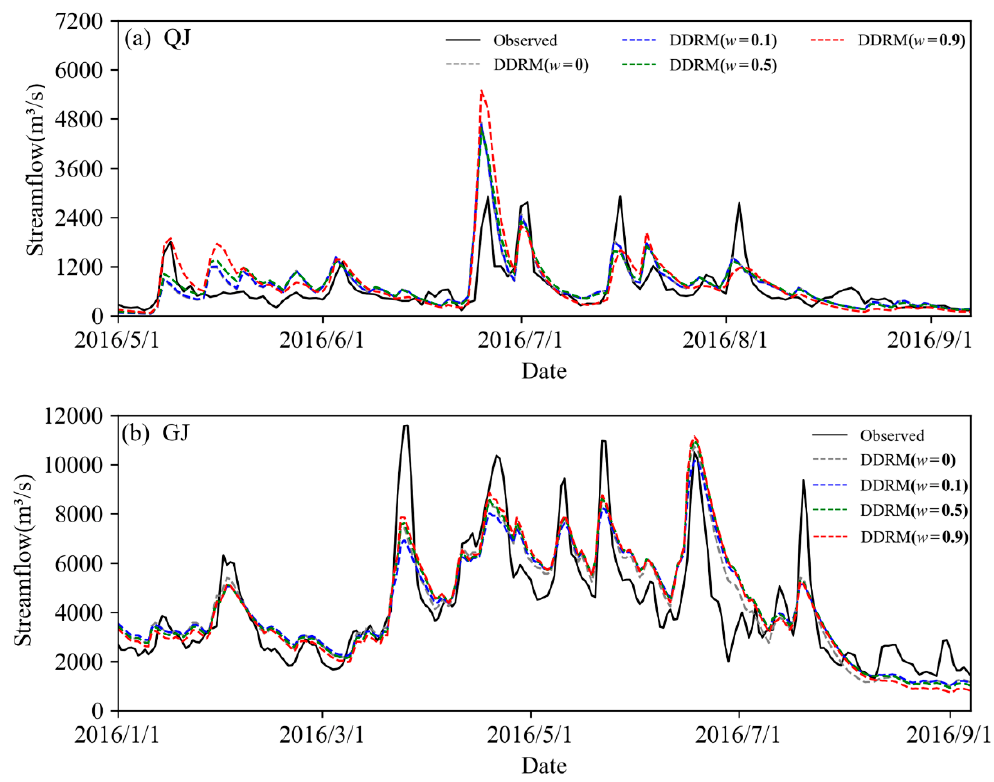
Figure 4. Comparison of observed streamflow and DDRM-simulated streamflow under four calibration schemes ( w = 0, w = 0.1, w = 0.5, w = 0.9) for ( a ) QJ and ( b ) GJ.